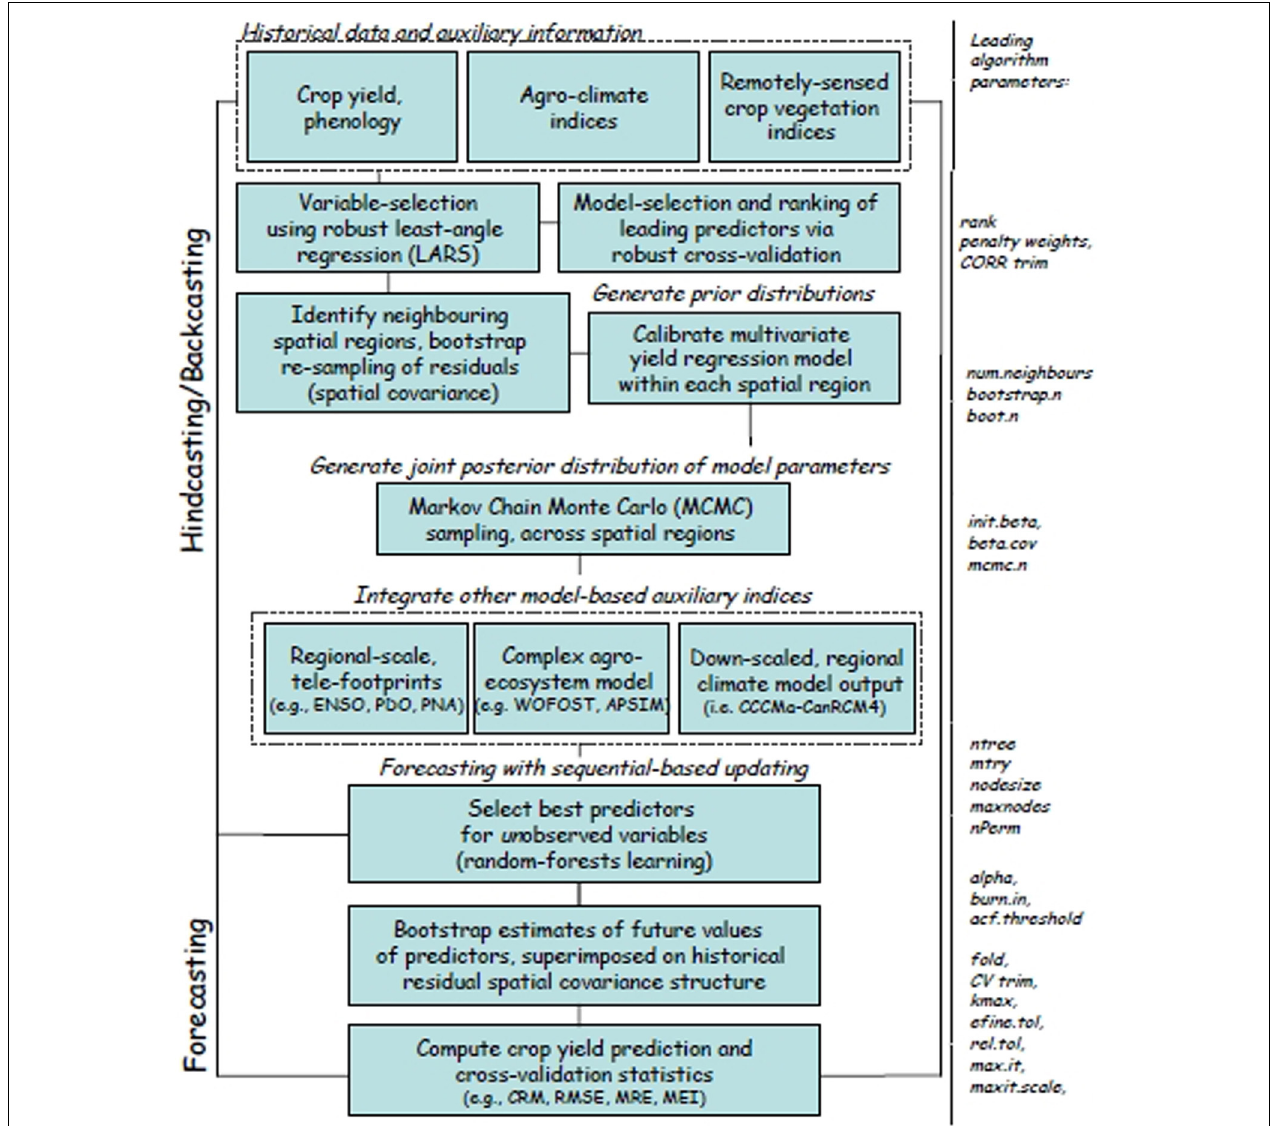
FIGURE 2 | Major components of the sequential, spatial-based Bayesian forecasting model of regional-scale crop yield. Model parameters that are tuned and fixed within each model component are identified to the right. The procedure consists of calibration and a prediction steps. Hindcasting/ backcasting via leave-one-out cross-validation (LOOCV) is performed using the input data as training data. Sequential-based forecasting is accomplished via the random-forests learning algorithm. This methodology is able to integrate other possible auxiliary historical indices, such as regionally-downscaled indices derived from El-Nino Southern Oscillation (ENSO) index, Pacific Decadal (PDO), and the Pacific North American (PNA) climate